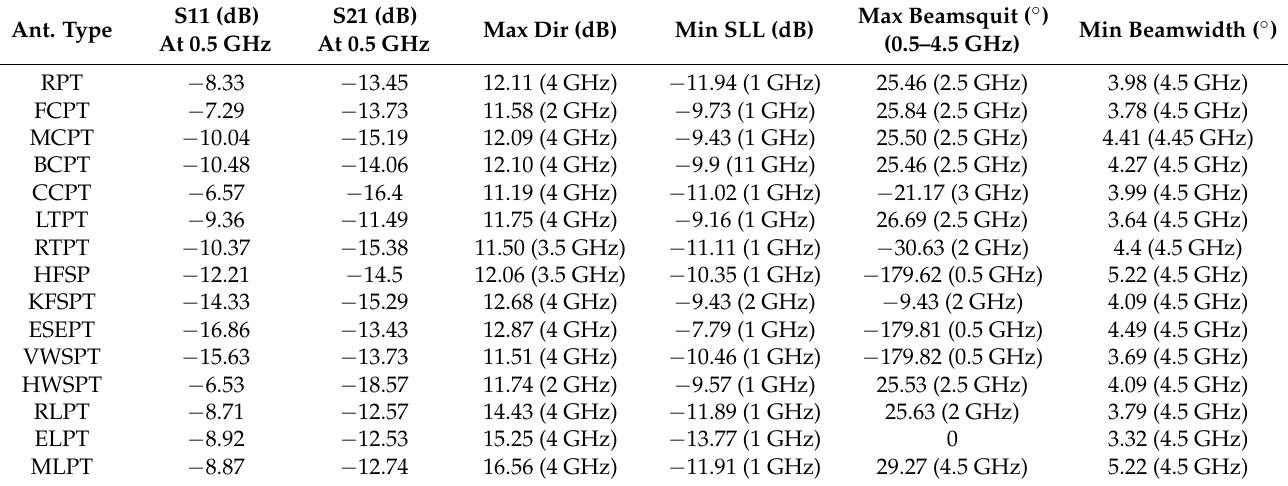
Table 3. 1 × 2 MIMO palm tree Coplanar Vivaldi